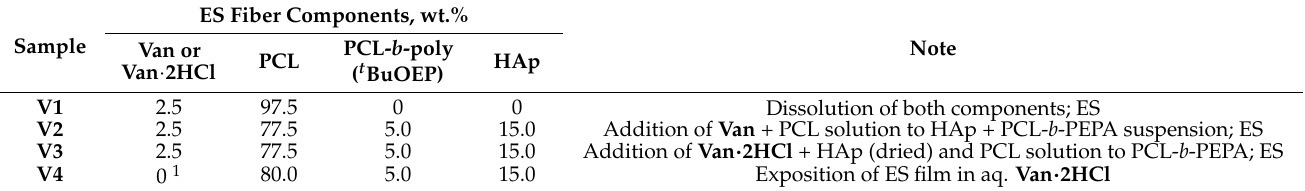
Table 3. Vancomycin-loaded ES fibrous